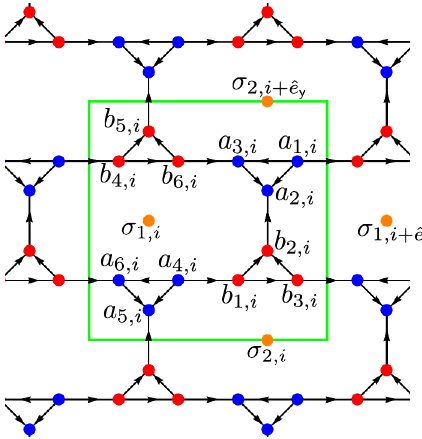
... a and b ... b . Correlations between 1 6 1 6